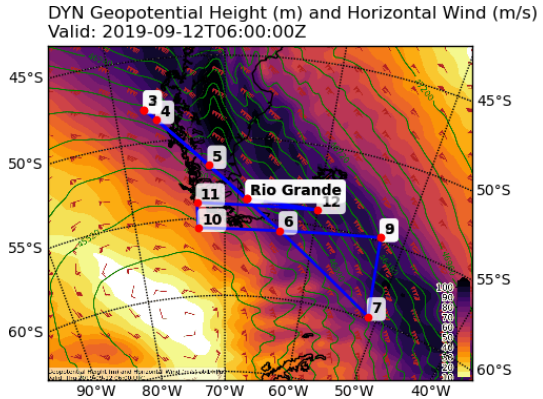
Figure 10. Horizontal wind speeds at 1hPa. Geopotential altitude (m) in green. Wind direction and magnitude also